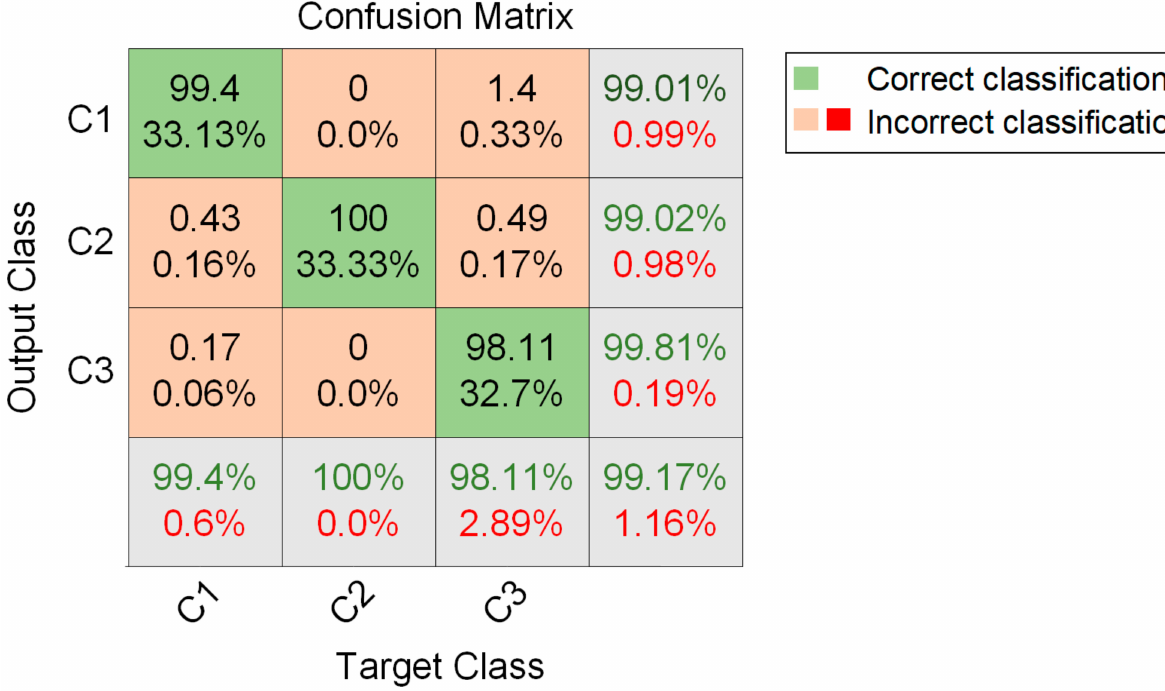
Figure 12. The confusion matrix denotes the test performance of the InceptionTime network using frequency-domain sequence